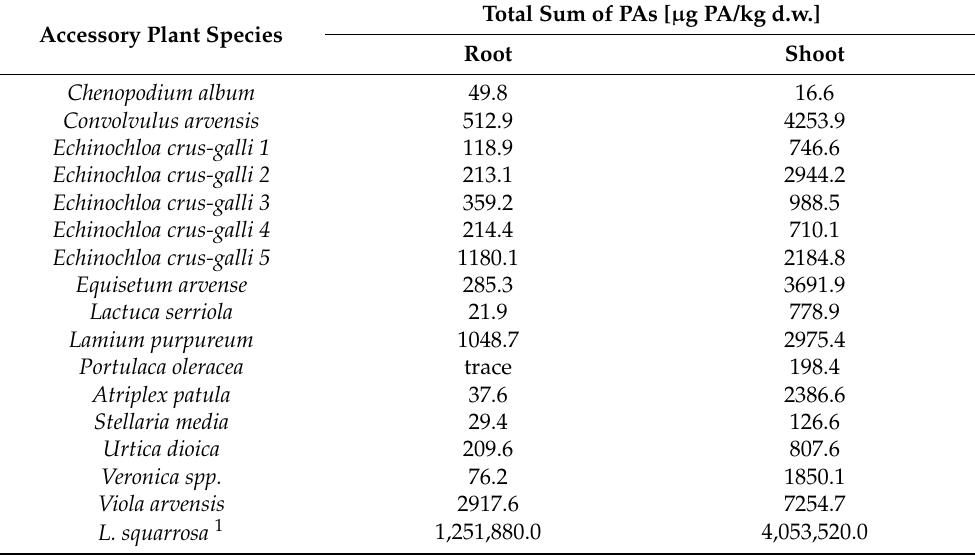
Table 1. PA-content caused by horizontal PA-transfer to non-PA-accessory plants growing in L. squarrosa cultivations (Plot A, Figure